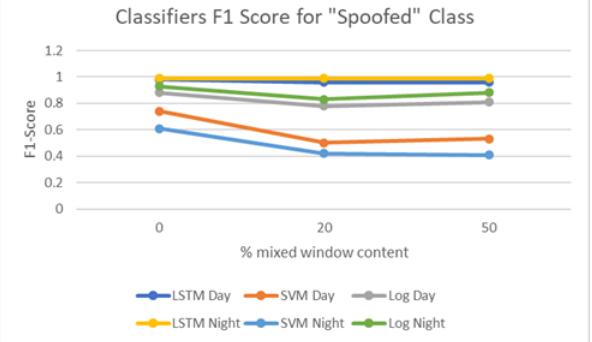
Figure 12. Comparison of ‘Spoofed Classification’ of our novel detection method with two other [13,23] state-of-the-art approaches proposed in the